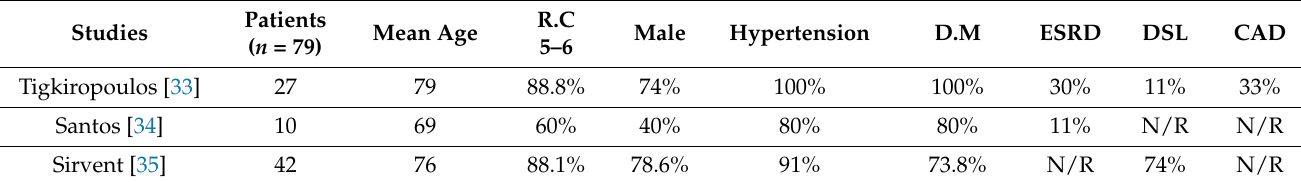
Table 2. Baseline patients’ characteristics in 3 studies.